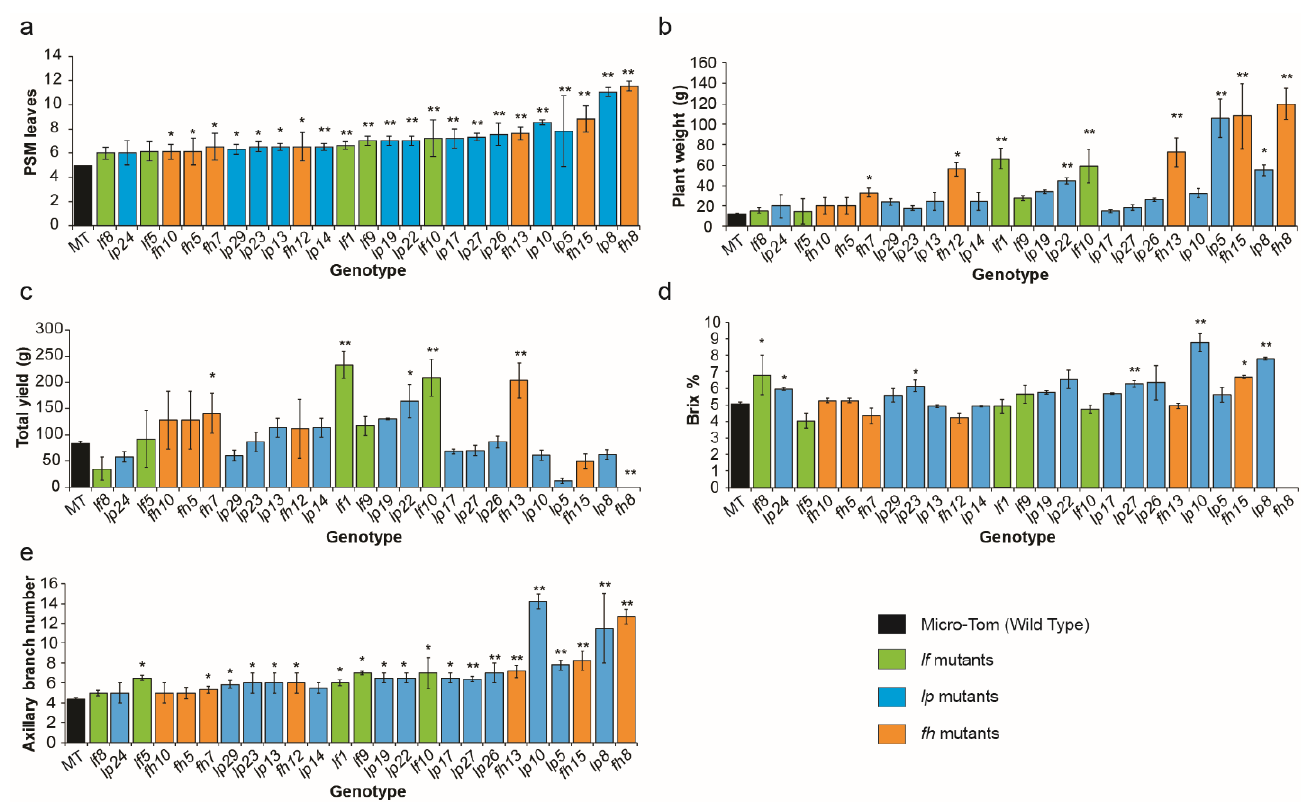
Figure 3. Quantifications of tomato yield-related traits of late-flowering variants in spring. Statistical comparisons of flowering time ( a ), plant weight ( b ), total yield ( c ), Brix value ( d ), axillary branch number ( e ) collected from late-flowering variants. Three phenotypic mutant groups categorized as lf (green color bars), fh (orange color bars), and lp mutants (blue color bars) were arranged according to leaf number produced by PSM. Mean values ( ± s.e.m.) were compared to those for wild-type and mutants categorized into three groups using Student’s t -tests (*, p < 0.05; **, p <